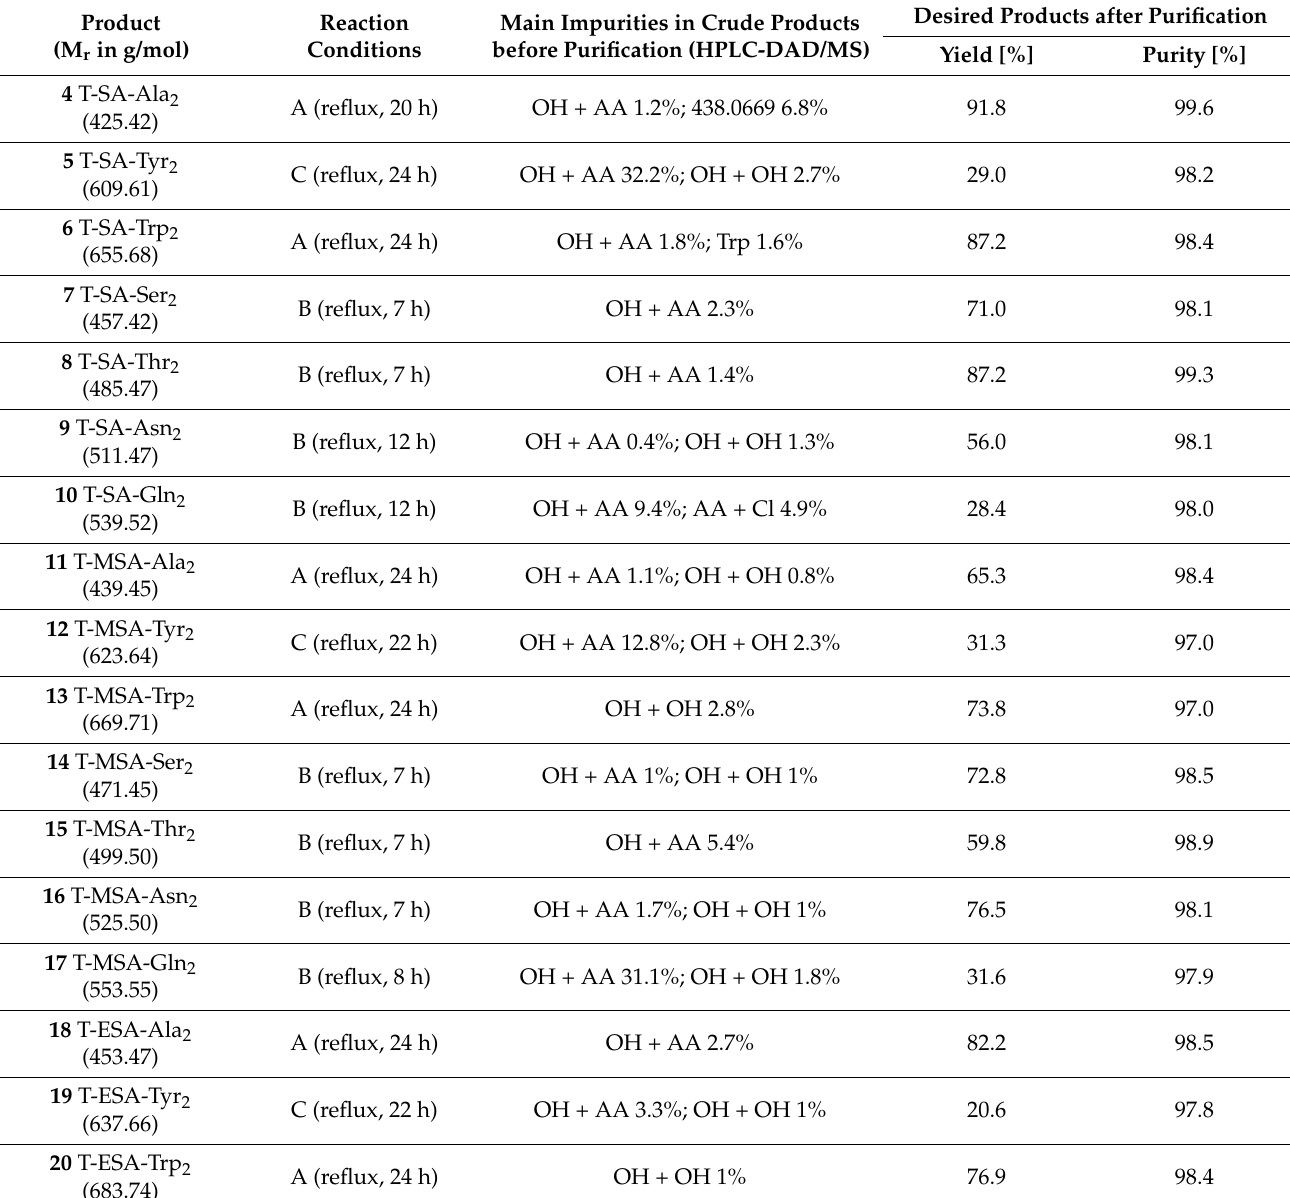
Table 1. Optimized reaction conditions, characteristic impurities of synthesized products, yields, and purities of the LC-purified desired